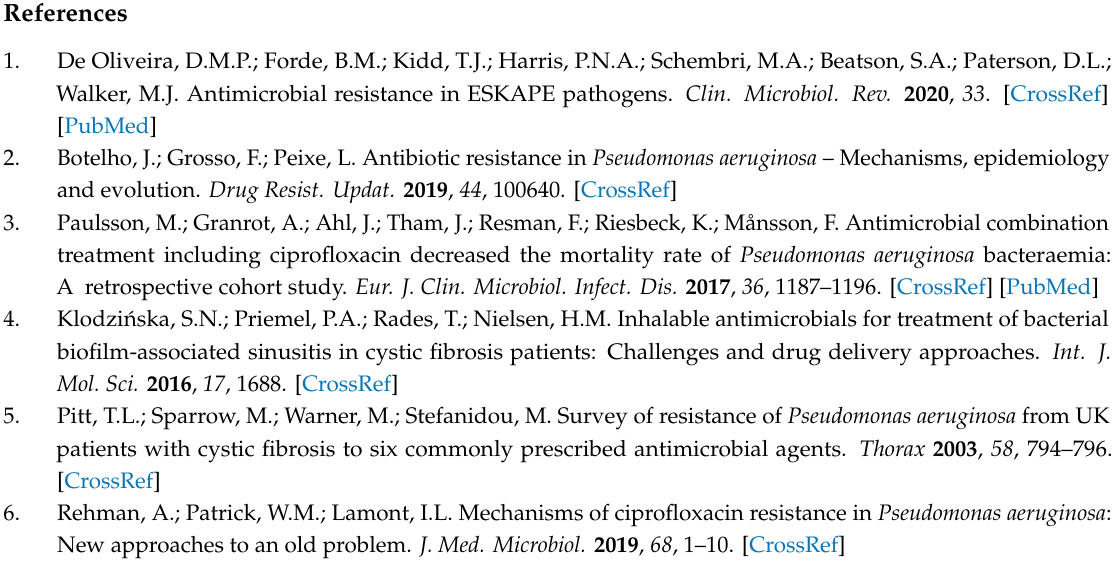
Figure S1: Graph with the frequency of genes versus the 215 P. aeruginosa complete genomes, Table S1: Accession numbers for the complete Pseudomonas genomes, Table S2: General features of the 134 crpP -harboring hits, Table S3: Average nucleotide identity (ANI) comparison between non- Pseudomonas aeruginosa strains identified in this study and the P. aeruginosa reference strain, Table S4: General features of the crpP -carrying ICEs, Table S5: Macsyfinder reports for the ICE proteomes, Table S6: Functional annotation of the ICE